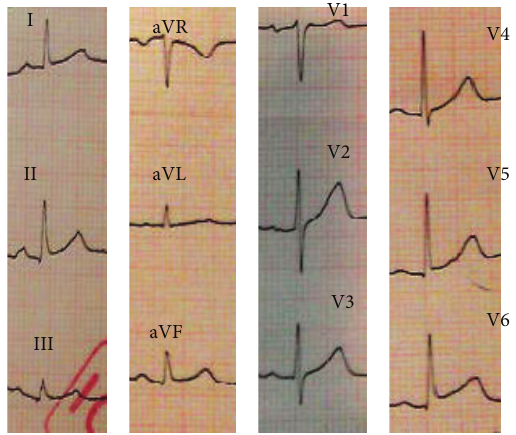
Figure 1: Initial electrocardiogram of the patient at the admission